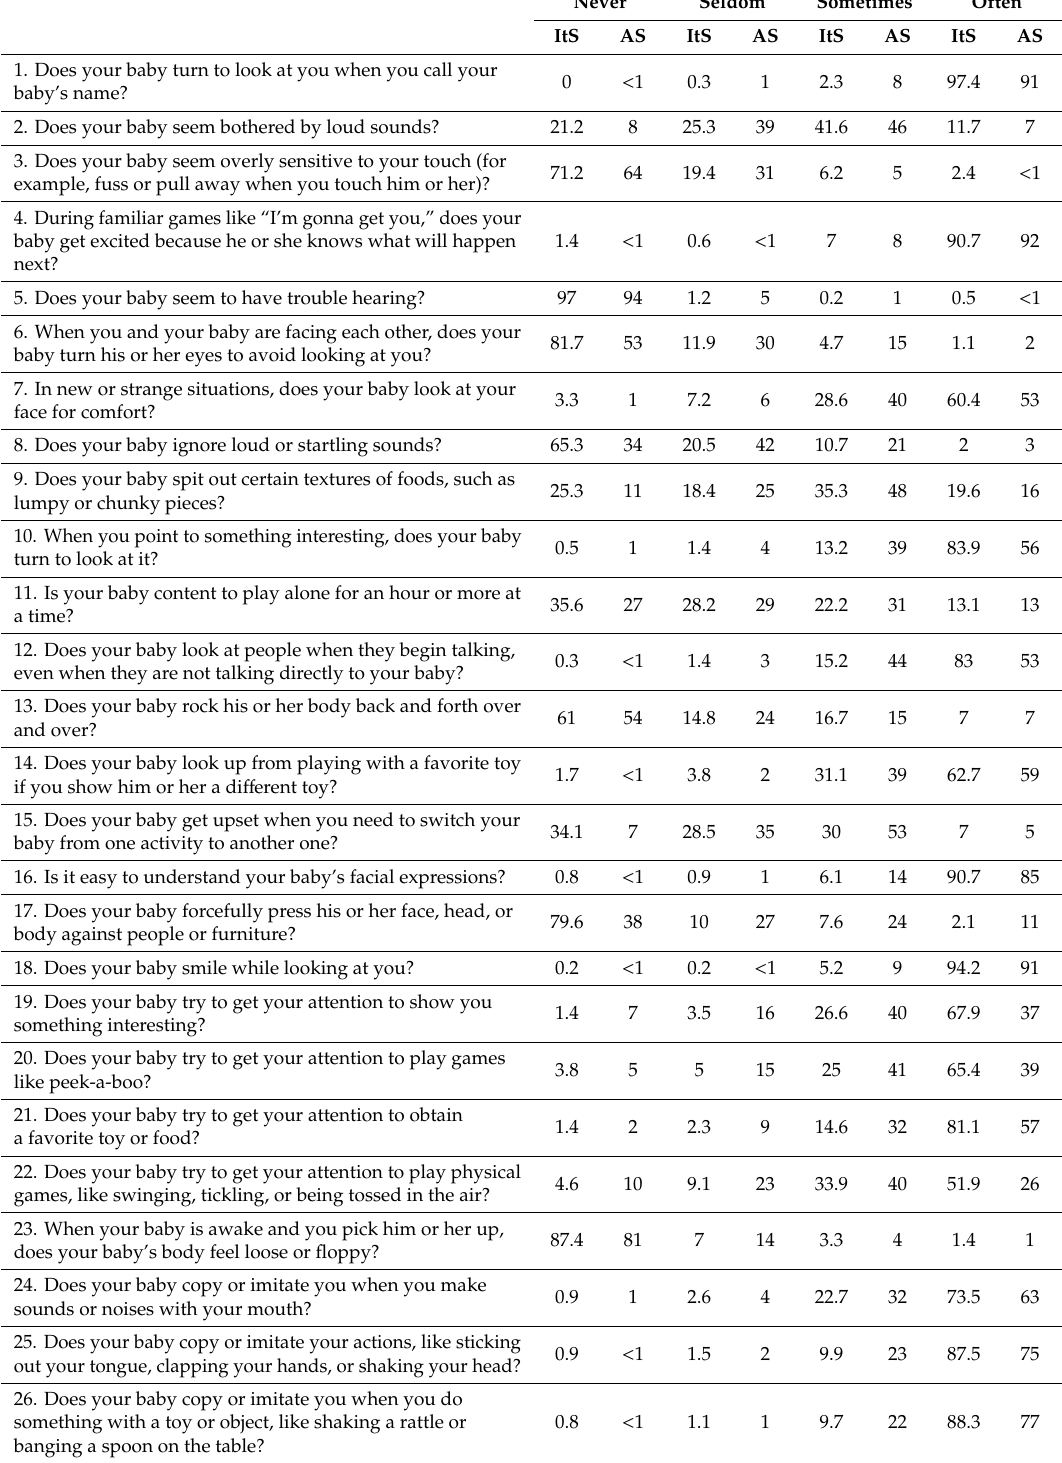
Table 3. Chi-square comparison between American (AS; Reznick et al., 2007) and Italian (ItS) sample distribution